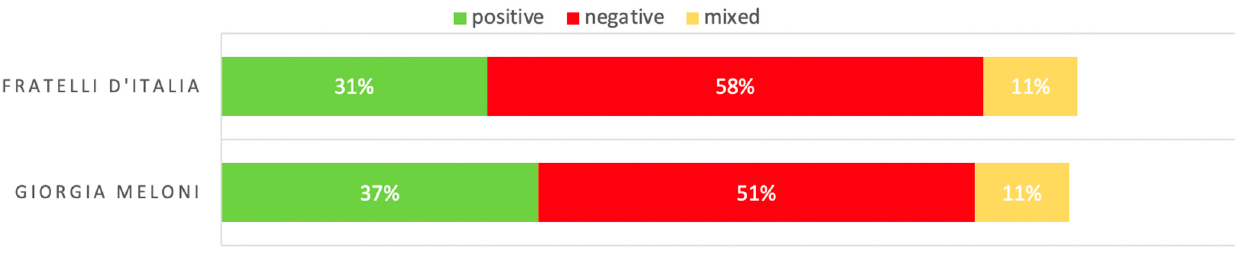
Figure 7. Automatic scanning by the tool FanPage Karma. Reference period: June 2021.